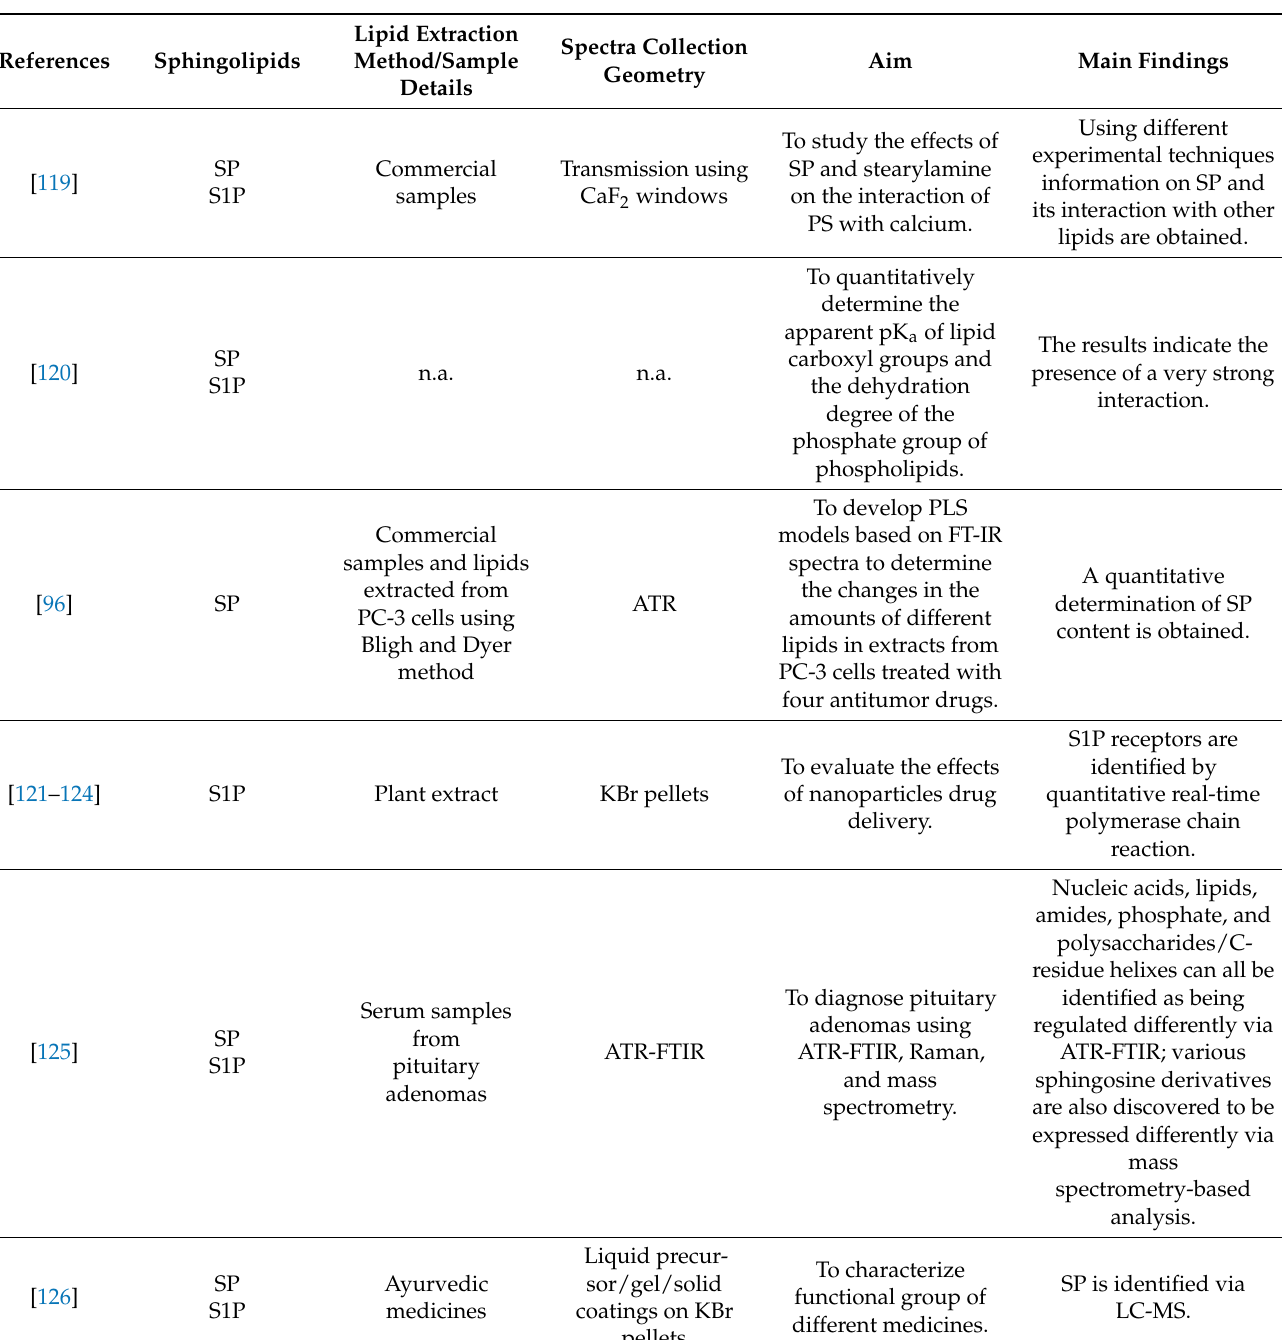
Table 6. Summary of some relevant results obtained on SP and S1P using different FT-IR spectroscopy